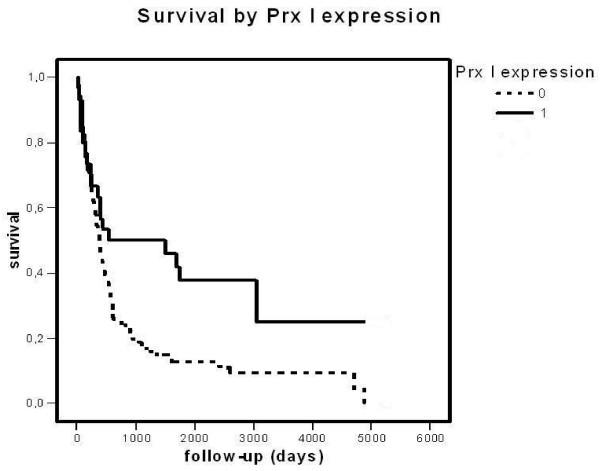
Survival by peroxiredoxin I in primary astrocytic brain tumors. Tumors were divided in two groups, Prx+ and Prx-. The difference between the groups is significant (p = 0.0052, log-rank test).